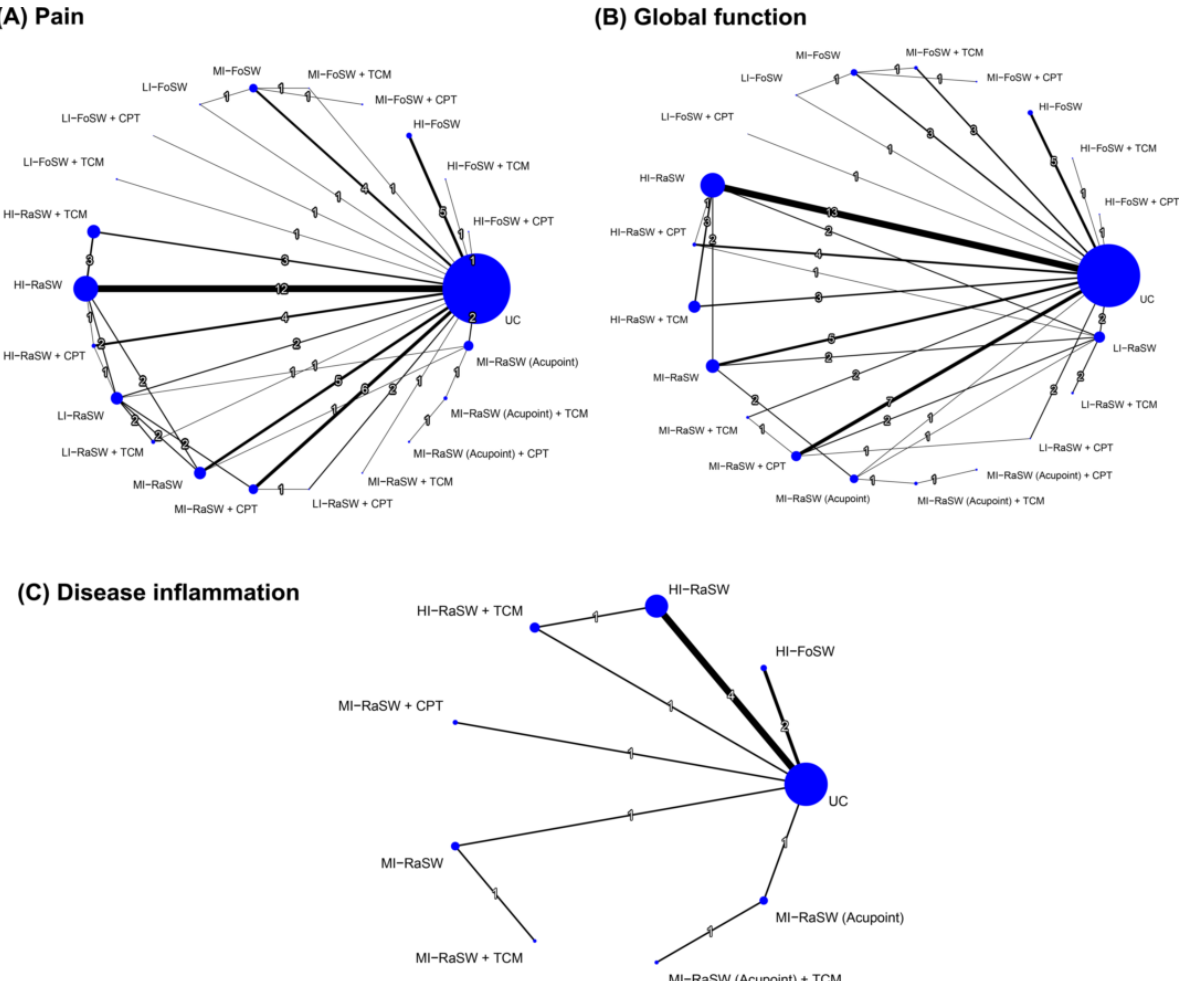
Figure 2. Network plot of the direct comparisons of different treatments for ( A ) pain, ( B ) global function, and ( C ) disease inflammation. The lines between nodes indicate direct comparisons in various studies. The size of each node is proportional to the number of the participants. The thickness of each line is proportional to the number of studies denoted on the line. FoSW, focused shockwave; RaSW, radial shockwave; HI, high energy; MI, medium energy; LI, low energy; CPT, conventional physical therapy; TCM, traditional Chinese medicine; UC, usual care.